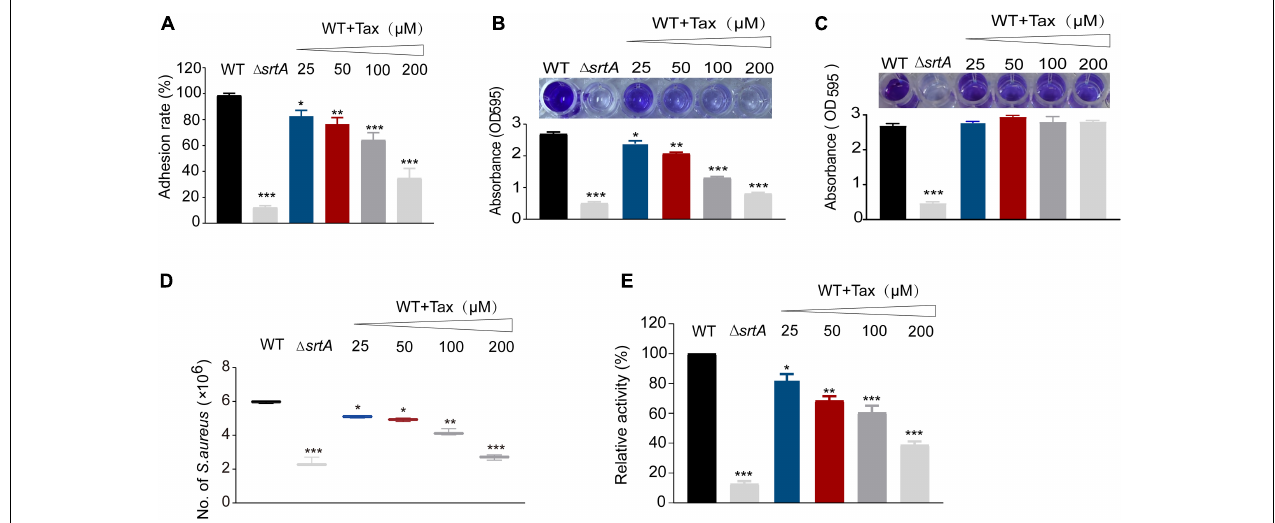
FIGURE 3 | Effect of SrtA inhibitor on virulence-related phenotypes in S. aureus Newman strain. (A) Impact of Tax on the ability of S. aureus to adhere to fibrinogen. (B) Biofilm formation of S. aureus in the presence of different concentrations of Tax. (C) Mature biofilms of S. aureus in the presence of different concentrations of Tax. The (cid:49) srtA group represented the positive control. (D) Tax affects internalization of S. aureus into A549 cells. A549 cells were infected with S. aureus pretreated with different concentrations of Tax then lysed 2 h post-infection. The number of viable S. aureus in the cells was quantified by serial dilution on TSA agar plates. (E) Effects of Tax on S. aureus protein A (SpA) using FITC-labeled rabbit IgG. Error bars represent means ± SD of three replicates. * P < 0.05, ** P < 0.01, *** P < 0.001 calculated with a two-tailed Student’s t